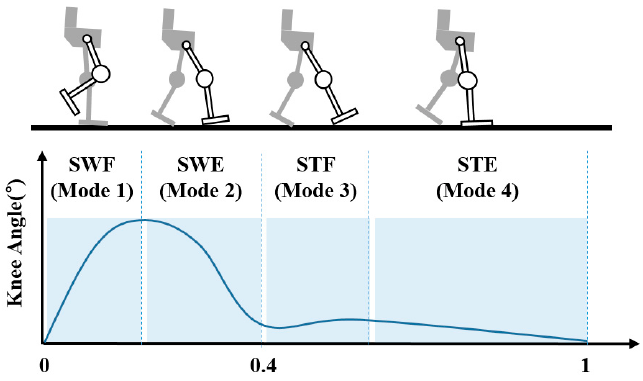
Figure 6. Classification of exoskeleton orthosis gait into four functional modes for level walking.